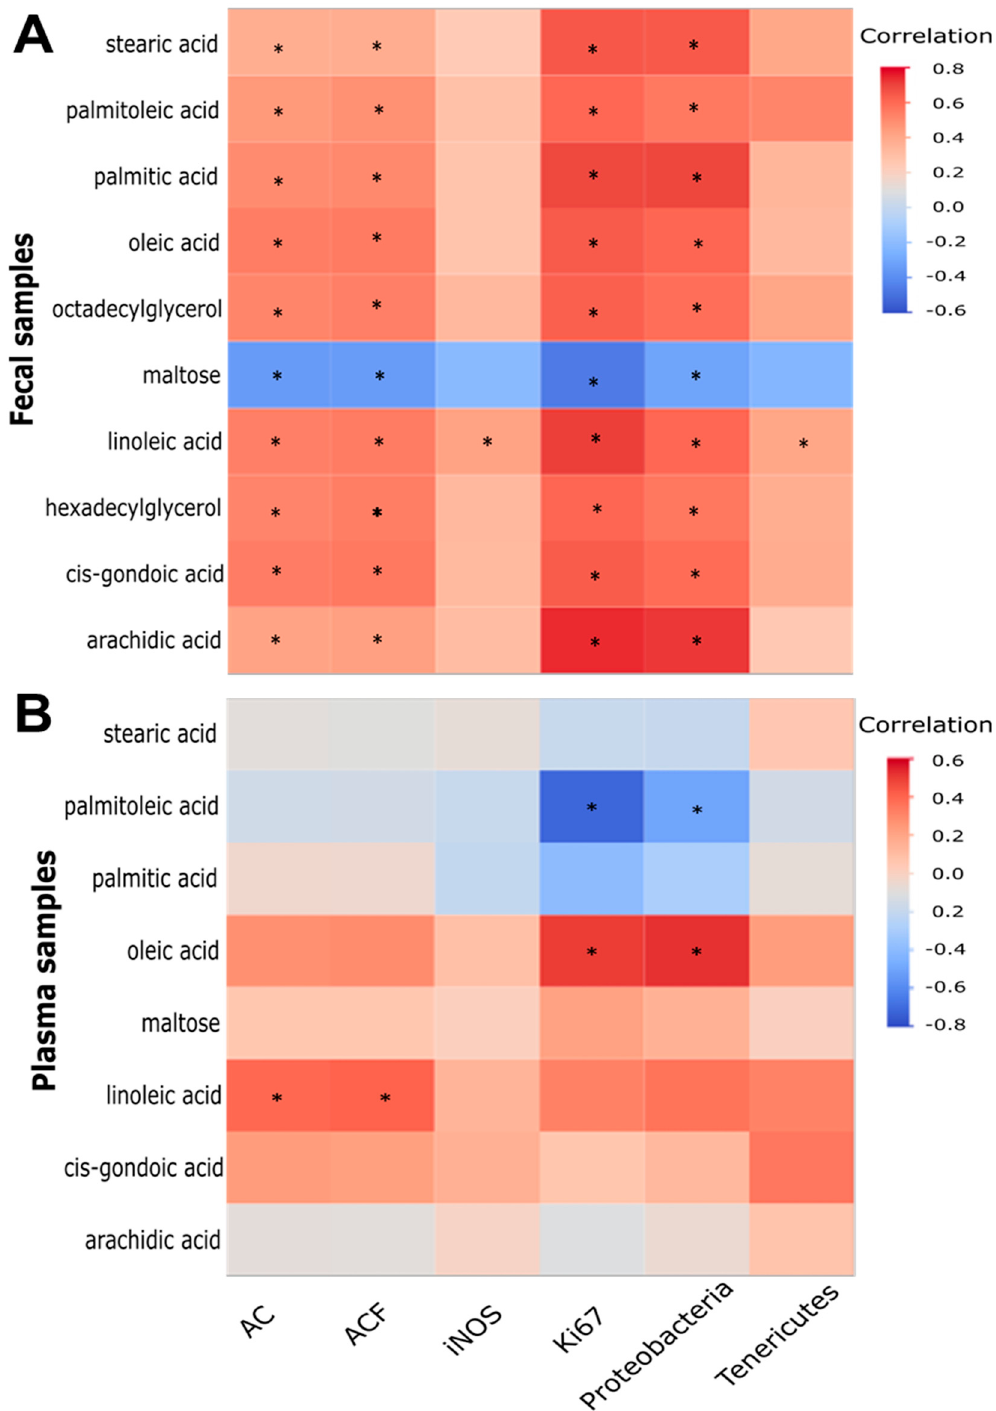
Figure 5. Correlation between the concentrations of panel ( A )—the 10 metabolites of component 1 (Figure 1) or ( B )—the 8 plasma counterpart metabolites of component 1 in our previous study [13] **, the number of AC and ACF protein levels of iNOS and Ki67, and the abundance of Proteobacteria and Tenericutes in the ileum/colon in our previous study [8]. The heatmap color stands for a correlation coefficient r value. * p < 0.05, a significant FDR-adjusted Spearman correlation (n = 44 to 50). ** Octadecylglycerol and hexadecylglycerol could not be detected in the plasma samples in our previous study [13].